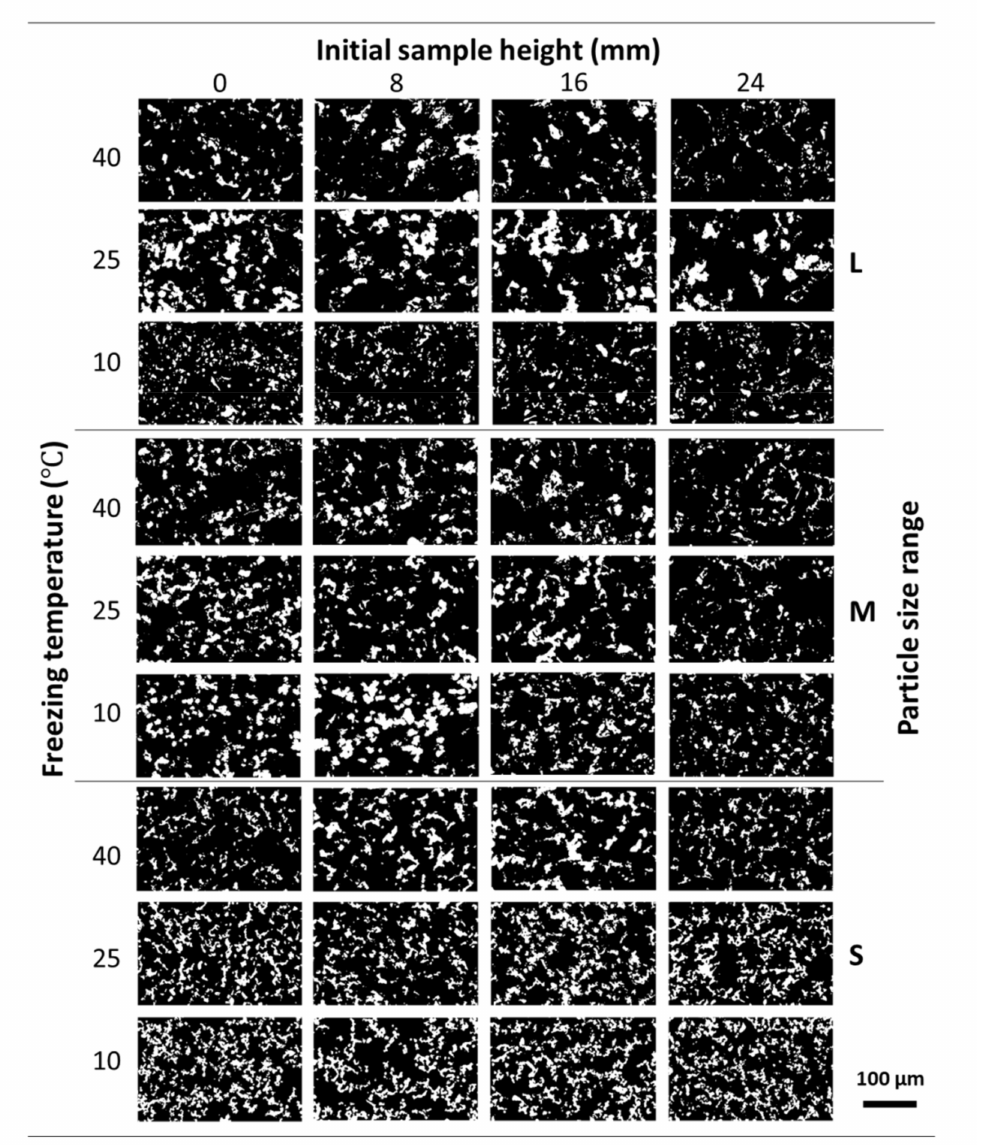
Figure 2. Evolution of the pore structure of the Ni wicks sintered at 800 ◦ C across the sample height. OM micrographs show the effect of the different particle size range (L, M, and S) and freezing temperature (40, 25, and 10 ◦ C) employed. Pores are shown in black and Ni walls were showed in white